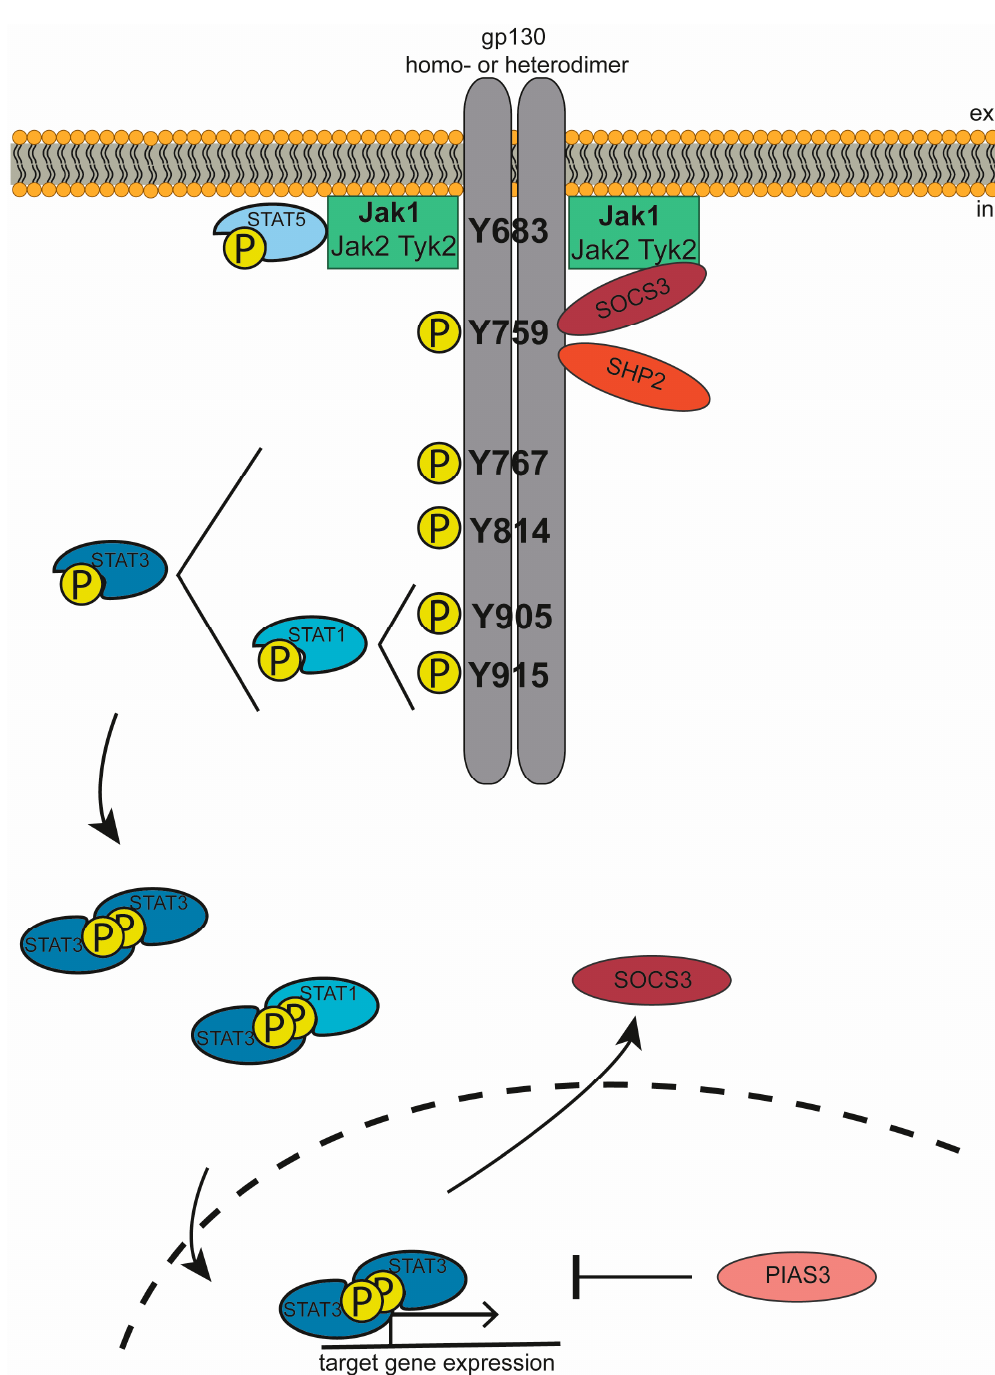
Figure 2. gp130-Mediated Jak / STAT Signaling. Upon cytokine binding, gp130 forms active homo-or heterodimers. This results in activation of intracellularly associated Janus kinases, which subsequently phosphorylate gp130 and STAT transcription factors, resulting in expression of target genes. Jak / STAT signaling is negatively regulated by SOCS3, PIAS3, and SHP2. More details are given in the main text.